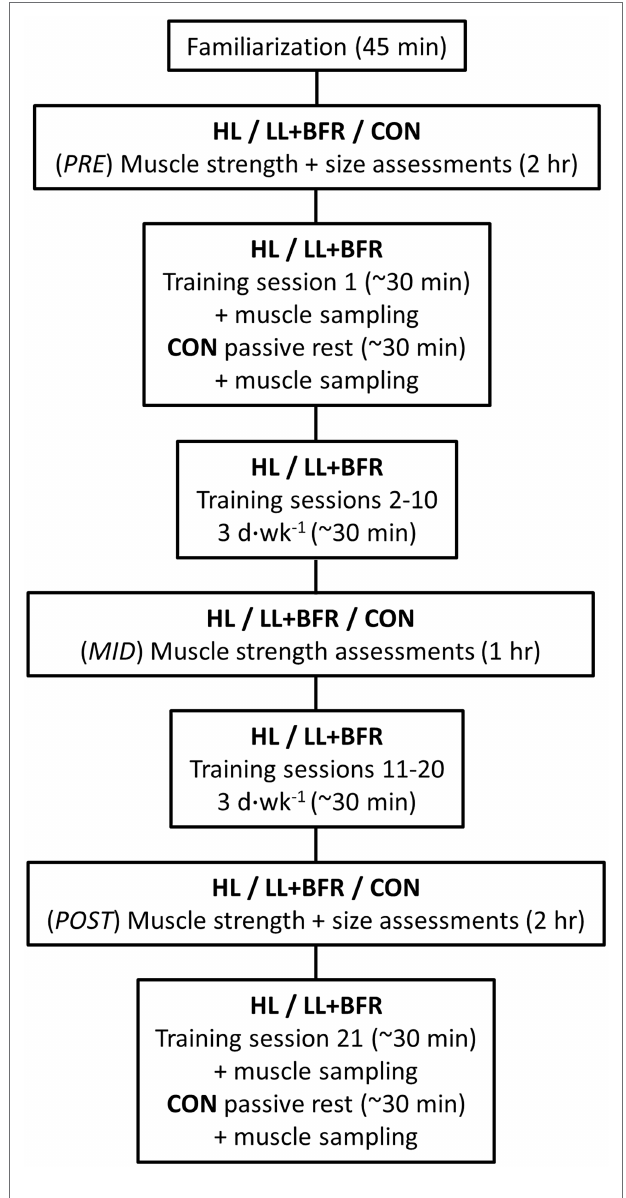
FIGURE 1 | Experimental protocol. HL, heavy-load resistance training group; LL + BFR, blood flow restriction training group; and CON, non-training control